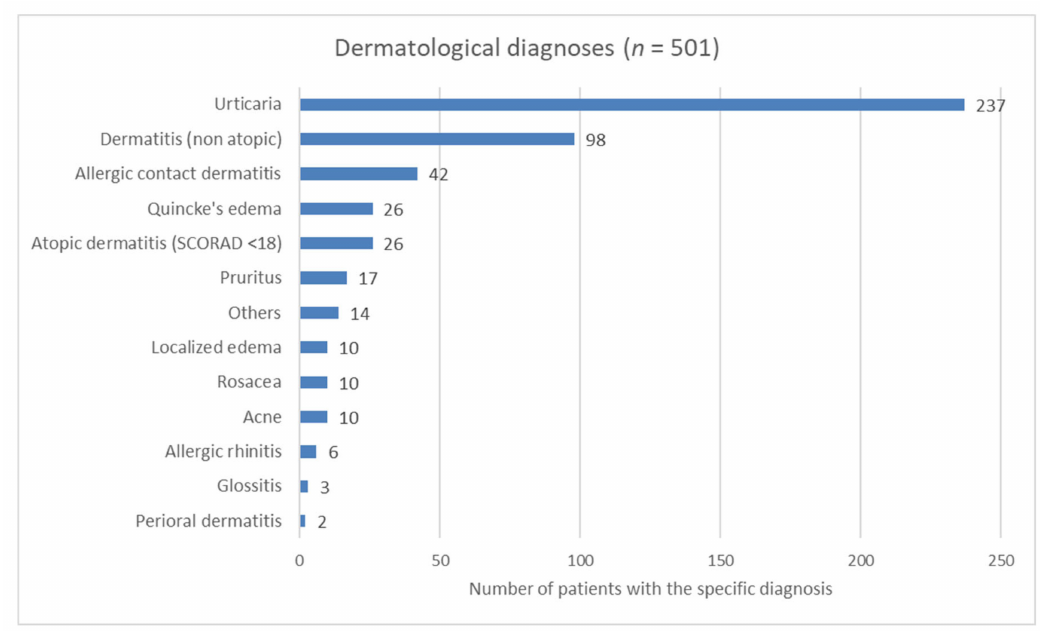
Figure 4. Dermatological diagnoses. SCORAD: SCORing Atopic Dermatitis.